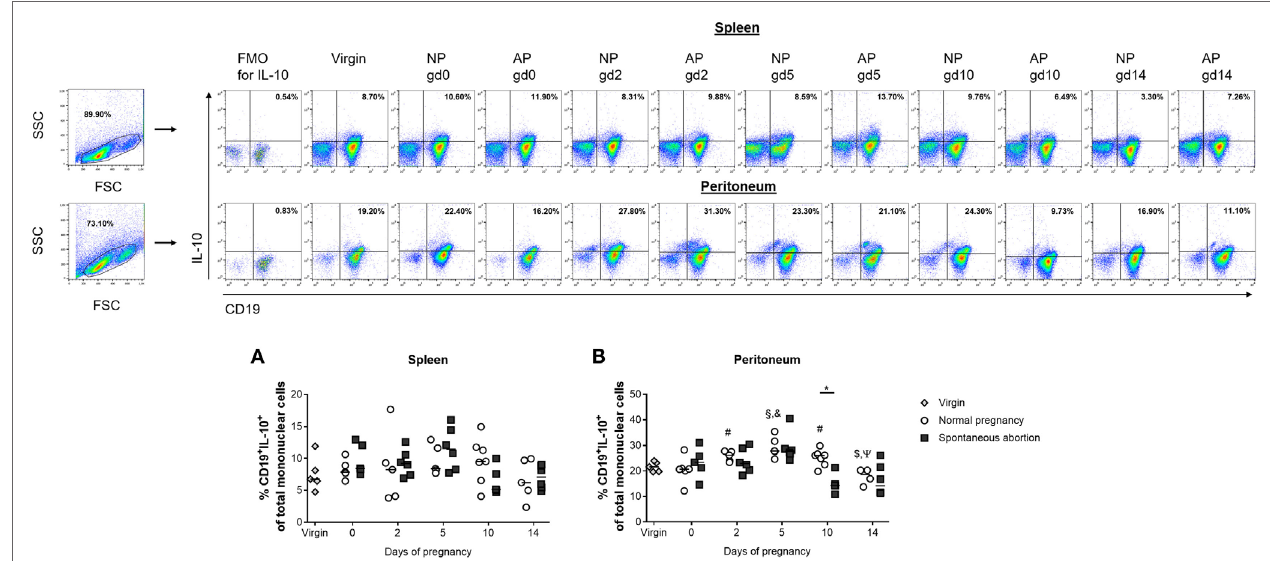
FigUre 1 | The frequencies of peritoneal CD19 + IL-10 + B cells were significantly reduced in abortion-prone (AP) females on gestation day (gd) 10. Virgin ( n = 5 per organ) as well as normal pregnant (NP, n = 4–7 per organ) and AP females ( n = 5–6 per organ) were analyzed at gd0, 2, 5, 10, and 14 for the frequencies of CD19 + IL-10 + B cells in spleen (a) and peritoneum (B) . Flow cytometry gating strategy and representative dot plots are included in this figure. Graphical data are displayed as medians. Each symbol represents a single animal, and the presented number of animals refers to pooled data of at least two independent